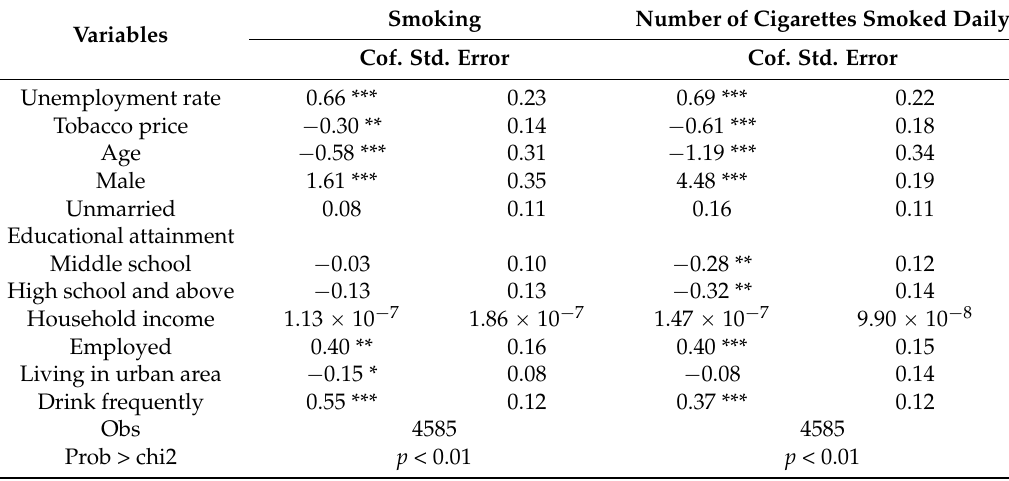
Table 2. Effects of unemployment rate on smoking behavior.